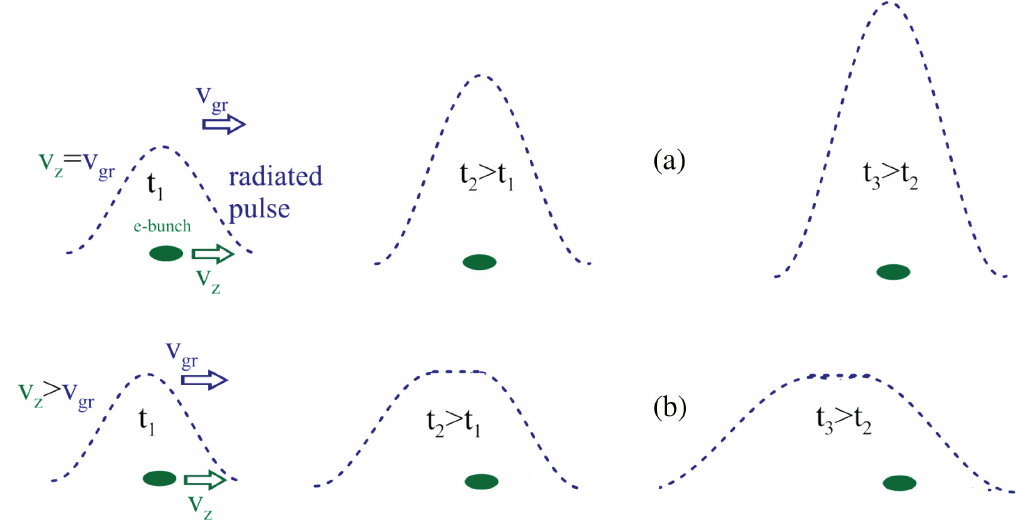
FIG. 5. (a) The radiated wave pulse in the case of the superradiant emission in the group resonance regime. (b) The radiated pulse “ slips ” with respect to the electron bunch in the case when the electron velocity differs from the wave group